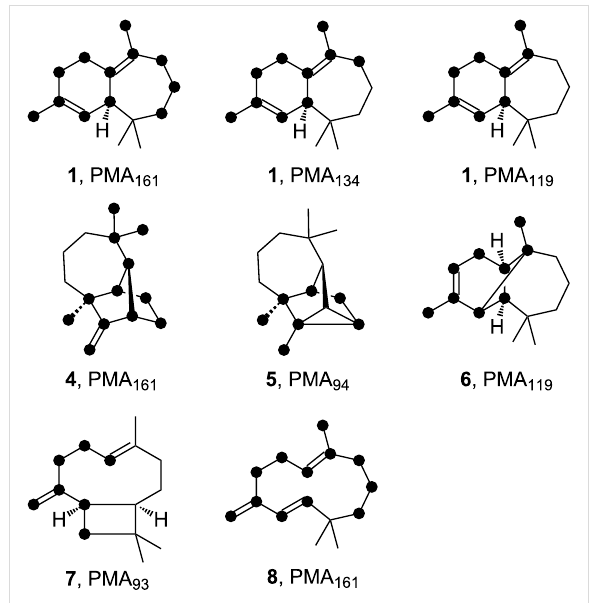
Figure 10: Position specific mass shift analysis for selected EIMS ions of HcS products. Black dots represent an increased mass of the ion ( m / z = +1) in case of a 13 C-labelling in this position. Proposed frag- mentation mechanisms for these ions are presented in Schemes S1–S3 (Supporting Information File